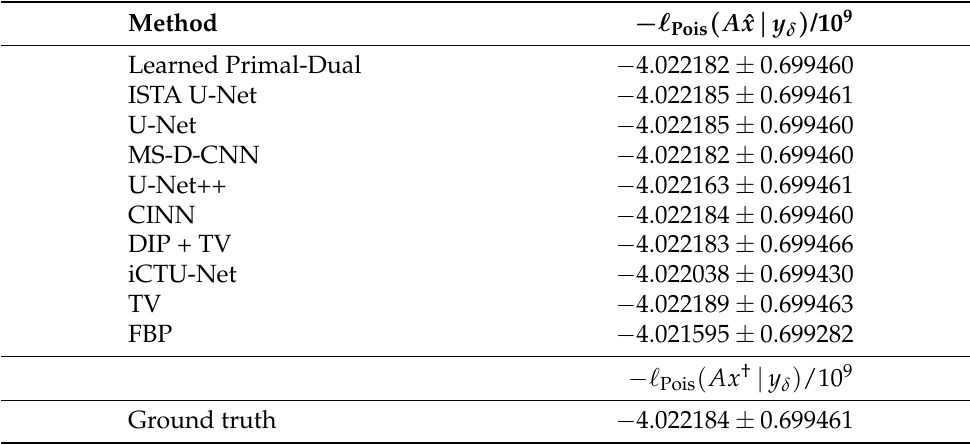
Figure 5. Mean data discrepancy − (cid:96) Pois between the noisy measurements and the forward-projected reconstructions, respectively the noise-free measurements. Evaluation is done on the LoDoPaB challenge images. Table 3. Mean and standard deviation of data discrepancy − (cid:96) Pois . Evaluation is done on the LoDoPaB challenge